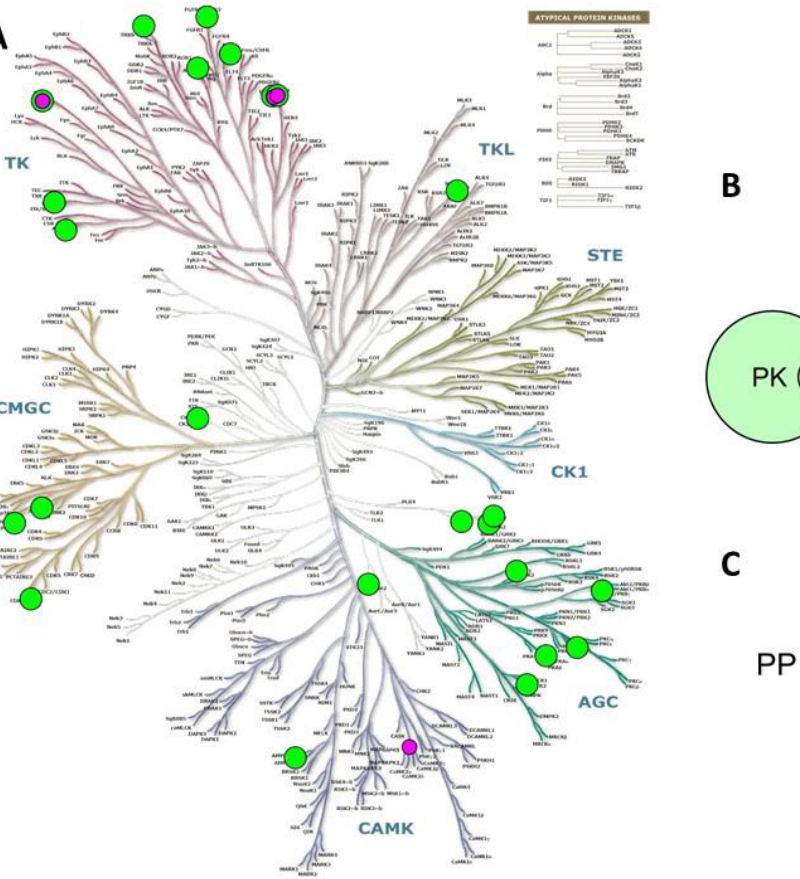
Figure 6. Class 3A and Class 3B probes: kinome coverage and principle of functioning. ( A ) Human PKs for which Class 3A (green circles) or Class 3B (magenta circles) probes have been reported (kinome tree adapted from [104], illustration generated by analog of software available at [105]). ( B ) Example of Class 3A and Class 3B probe gaining photoluminescence after binding to target PK. ( C ) Effect of Class 3A and Class 3B probes on phosphorylation of endogenous substrates; blunt-end arrow denotes inhibition.